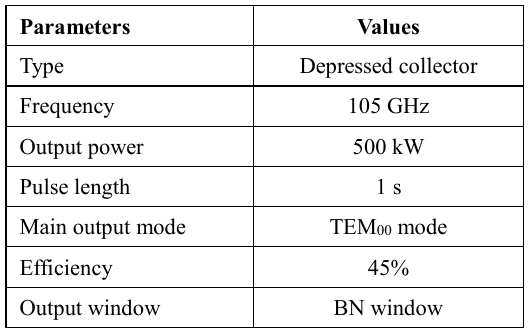
Table 2. Parameters of power supplies.